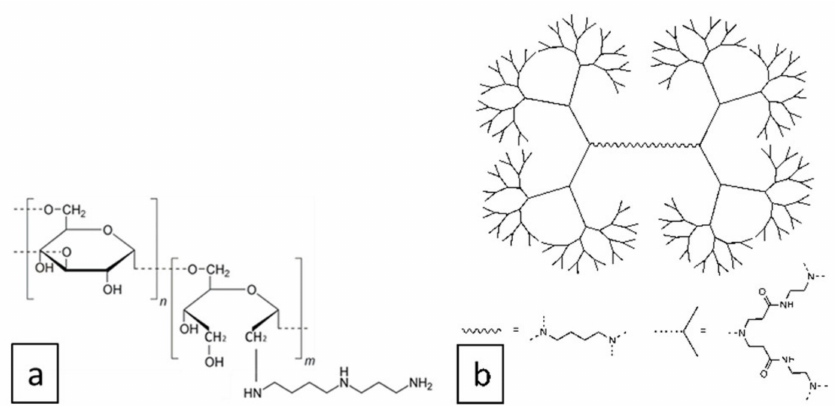
Figure 3. Structures of cationic polyglucin ( a ) and generation 4 polyamidoamine dendrimers ( b ) used in this